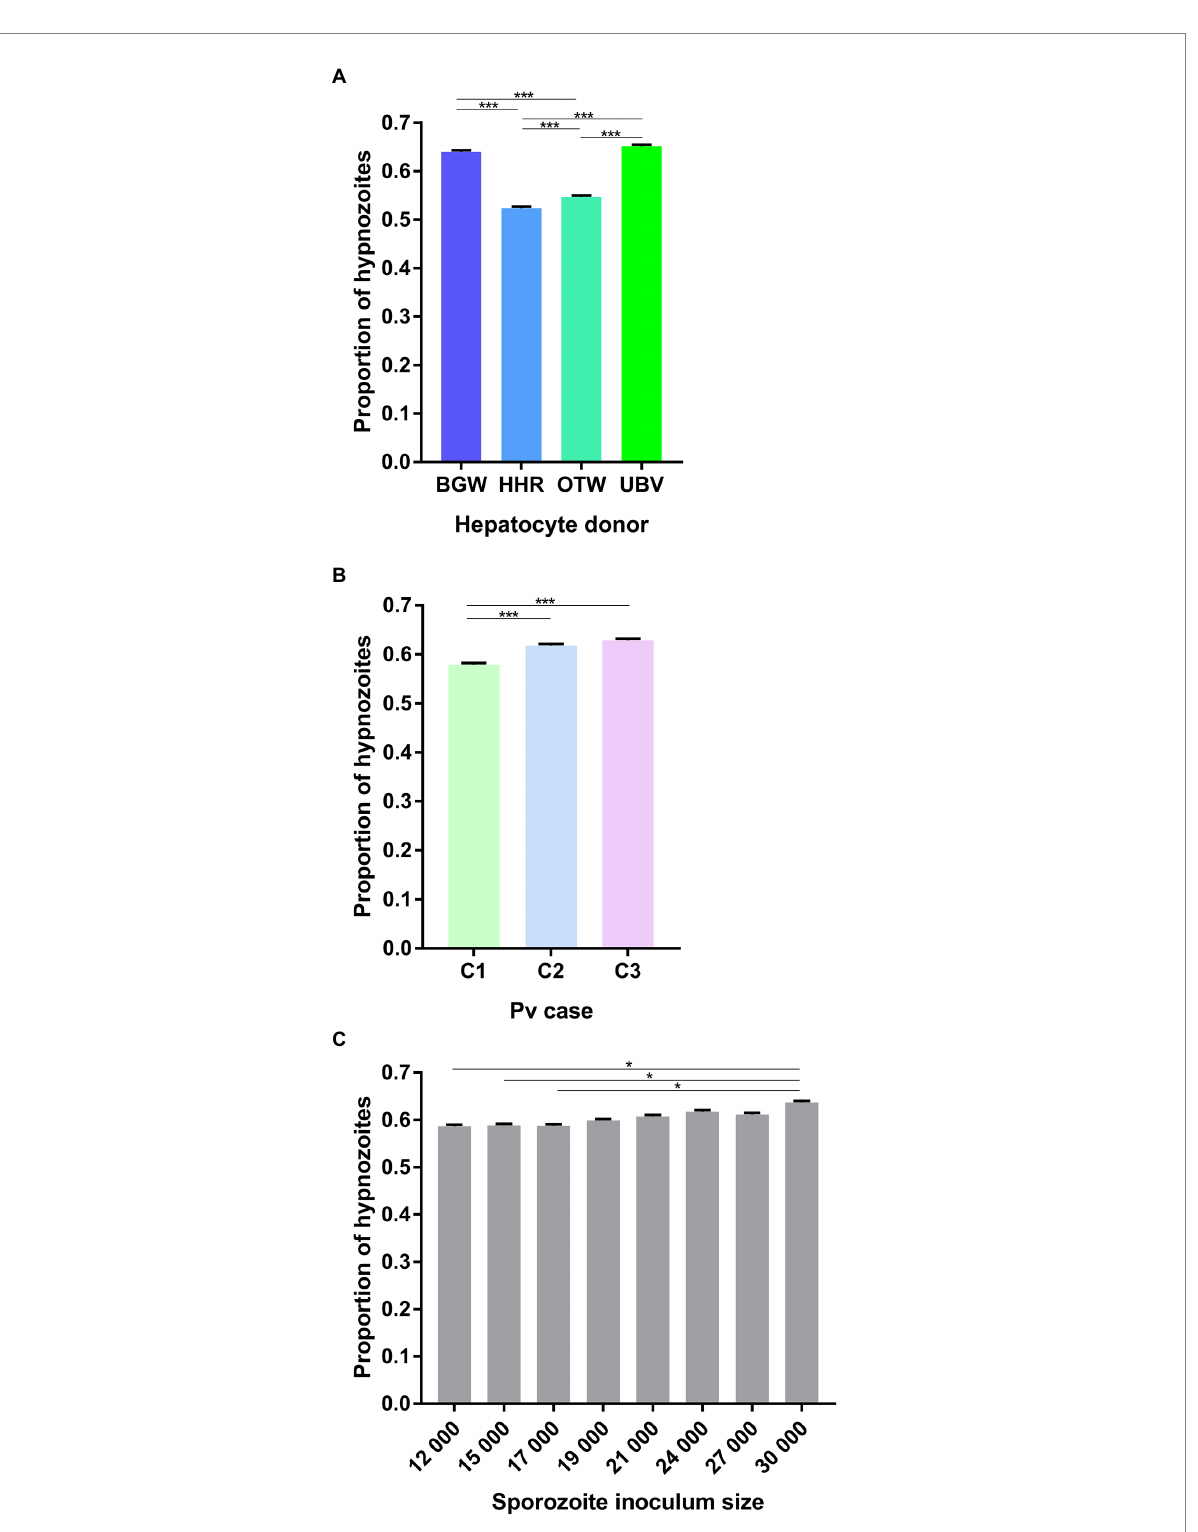
FIGURE 2 Analysis of the average proportion of P. vivax hypnozoites per well. Data include all parasites quantified from Experiment 1 in which four PHH donor lots (UBV, BGW, HHR, and OTW) were infected with three different P. vivax cases (C1 to C3) at eight sporozoite densities ranging from 12 × 10 3 to 30 × 10 3 per well and fixed at 8 days post-infection. Data are categorized by (A) PHH donor lot, (B) P. vivax isolate, and (C) sporozoite inoculum size. Asterisks indicate significant differences ( Post hoc Tukey’s pairwise comparisons, *** p < 0.0001, * p < 0.05). Bars represent ±95%